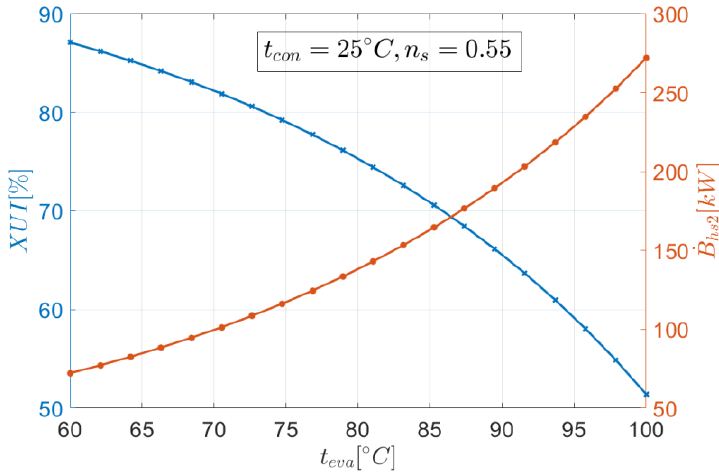
Figure 4. XUI and exergy flux 𝐵̇ ℎ𝑠2 of the heat carrier at the outlet of vapor generator as functions of evaporation temperature t eva.